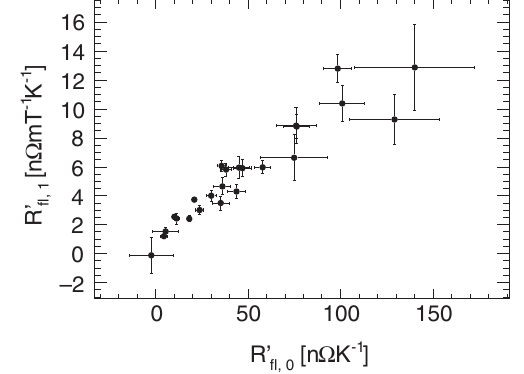
FIG. 13. Correlation plot of Δ T sensitivity of R